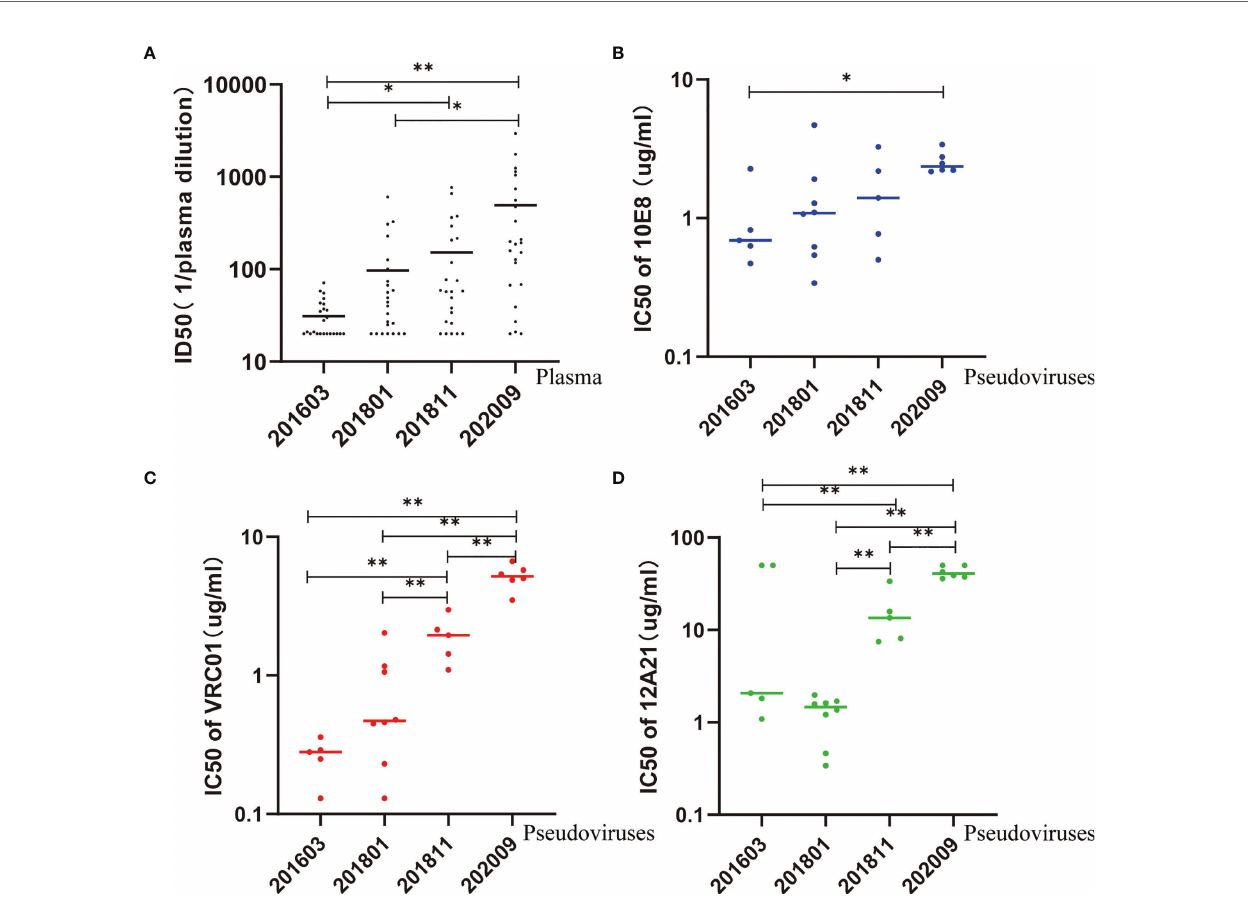
FIGURE 3 | Neutralization sensitivity of pseudovirus to autologous plasma and bNAbs. (A) ID50 values of autologous plasma increase over time, suggesting an increase in sensitivity. (B – D) IC50 values of 10E8, VRC01, and 12A21 increase over time, suggesting an increase in resistance. Kruskal – Wallis test performed to assess statistical signi fi cance. Representative data are shown (*p < 0.05; **p <